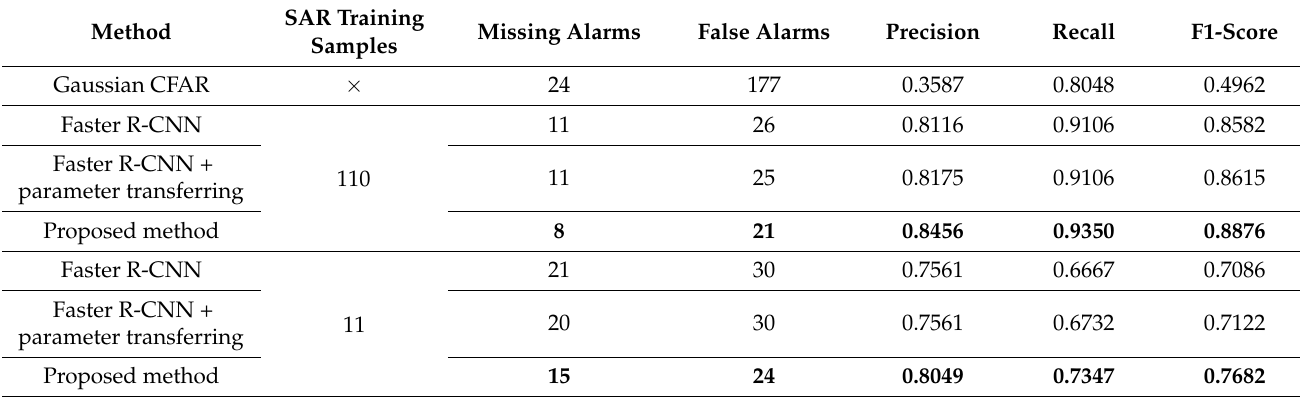
Table 1. Overall evaluation of different conventional target detection methods.